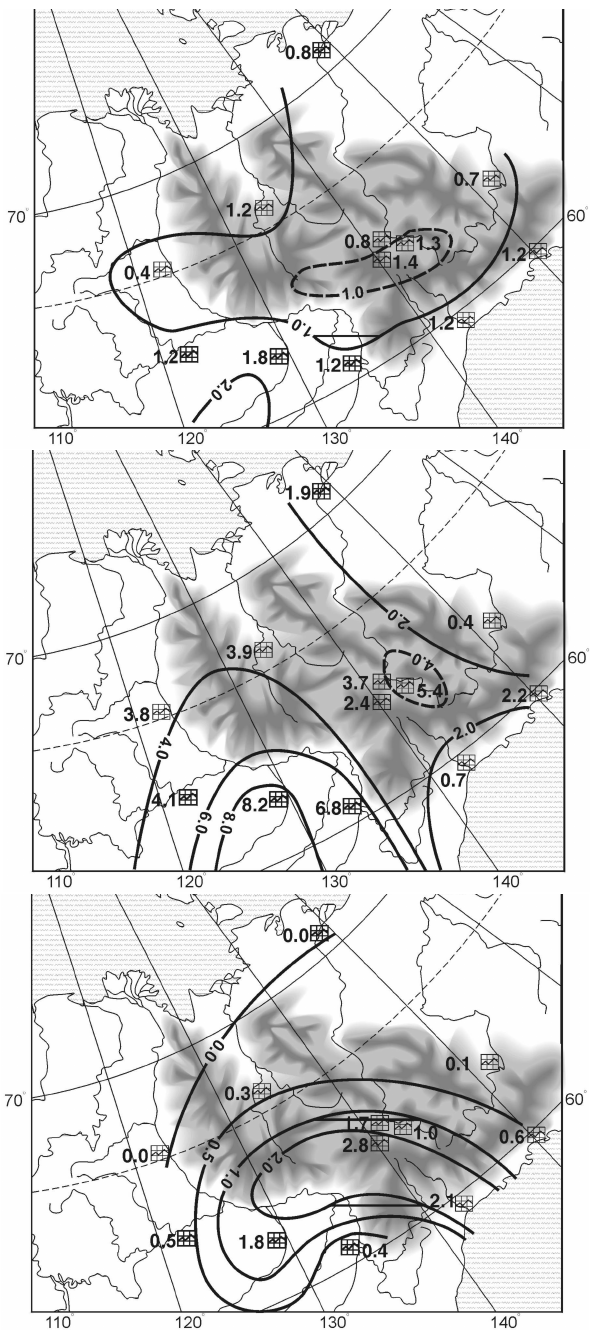
Fig. 3. Spatial distribution of positive temperature trends. (a) an- nual values for the warming up to 1995, T ◦ C/50 years, (b) winter trends for the same period, T ◦ C/50 years, (c) summer trends for the same period, T ◦ C/50